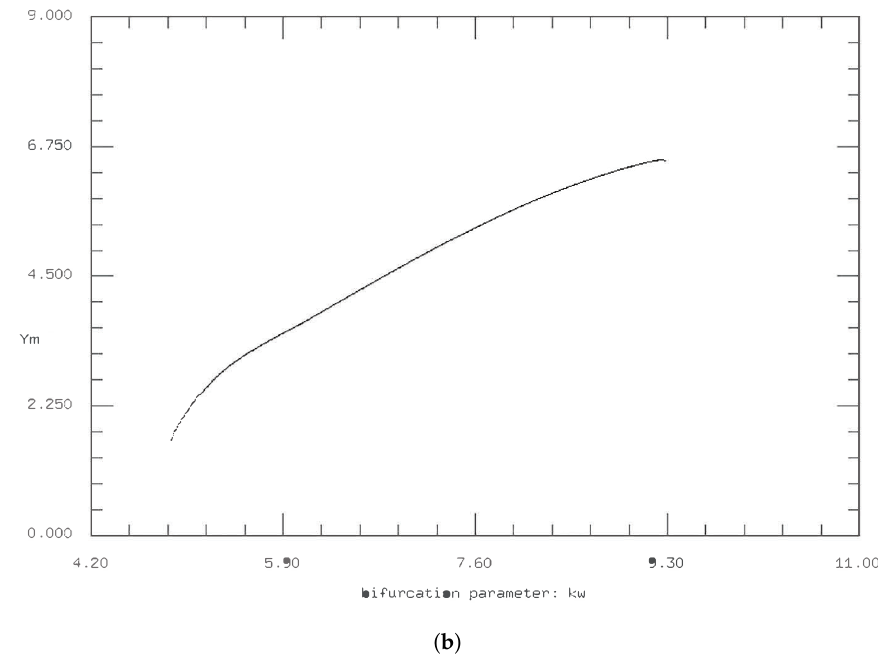
Figure 14. Bifurcation diagrams of k w for Y m with: ( a ) k fm = 0.005, and ( b ) k fm = 0.010 and other parameters from Table